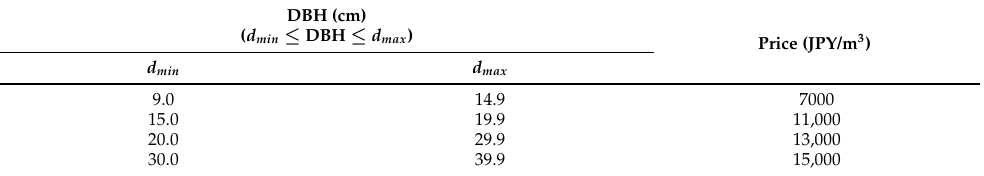
Table 1. Saw log price (DBH, diameter at breast